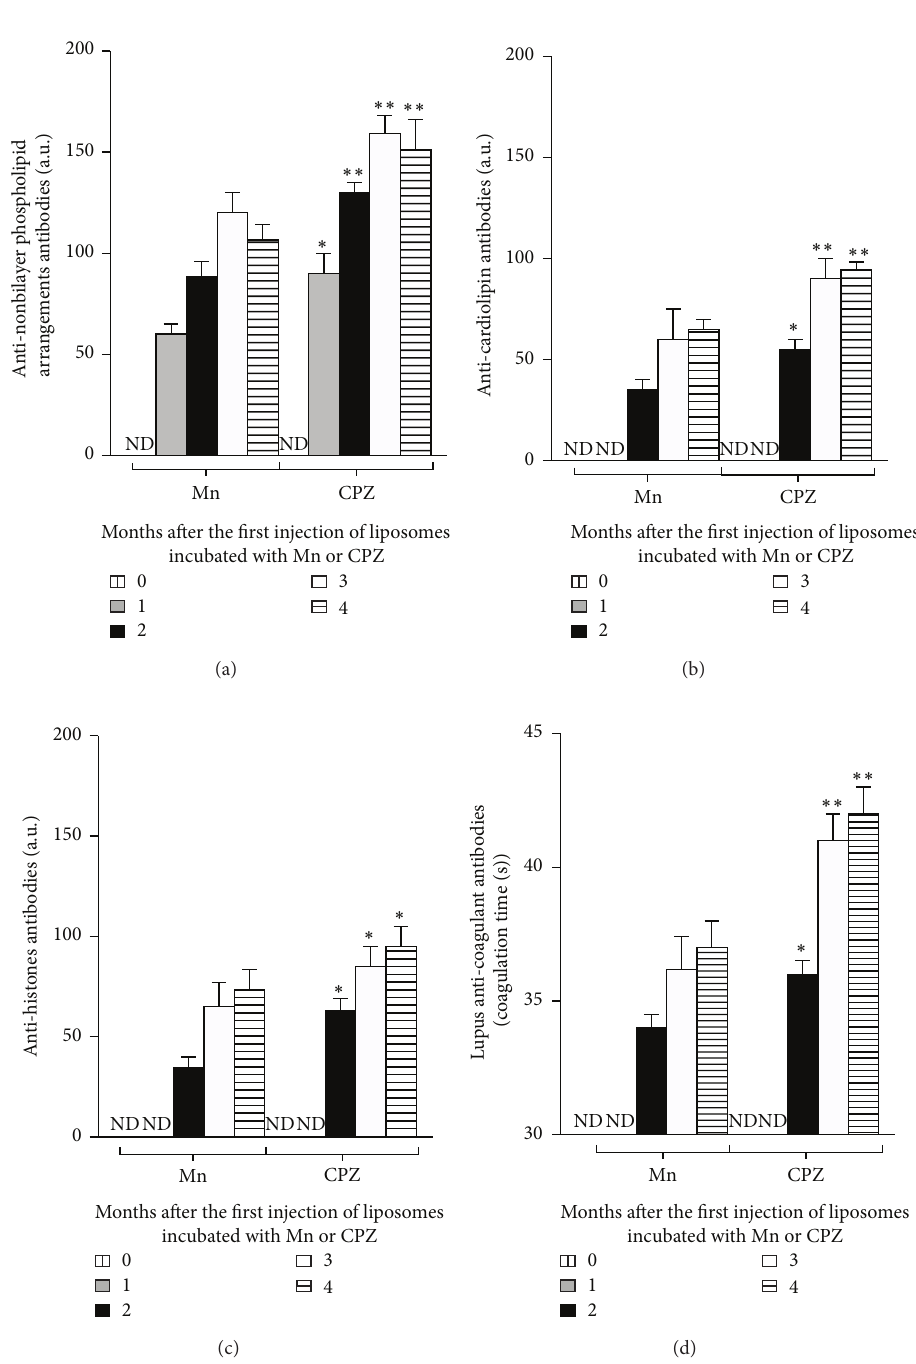
Figure 3: Antibodies found in the sera of mice with the disease resembling human lupus. Mice (10 per group) were injected with egg-yolk phosphatidylcholine/egg-yolk phosphatidic acid (2 :1) liposomes (50nmol phosphatidic acid in 50 𝜇 L TS buffer), alone (negative control) or incubated 30 min at 37 ∘ C with 5 mMMnCl 2 or 3 mM chlorpromazine (CPZ) to induce nonbilayer phospholipid arrangements. Mice injected with TS buffer were also used as negative control. (a) Anti-nonbilayer phospholipid arrangements, (b) anti-cardiolipin (CL), (c) anti-histone, and (d) lupus anti-coagulant antibodies were measured before and 1–4 months after liposome injection. Histograms represent the mean ± SD of three independent experiments. Control mice injected with TS buffer or with liposomes without nonbilayer phospholipid arrangements did not have detectable levels of any of these four antibodies, 1 or 4 months after the administration of TS or liposomes. ND: not detected. Data were analyzed with Kruskal-Wallis test with Dunn’s post-test (GraphPad Prism). ∗ 𝑝 < 0.05 ; ∗∗ 𝑝 < 0.01 . Asterisks indicate statistical significance between the antibody titers induced by liposomes incubated with CPZ and those incubated with